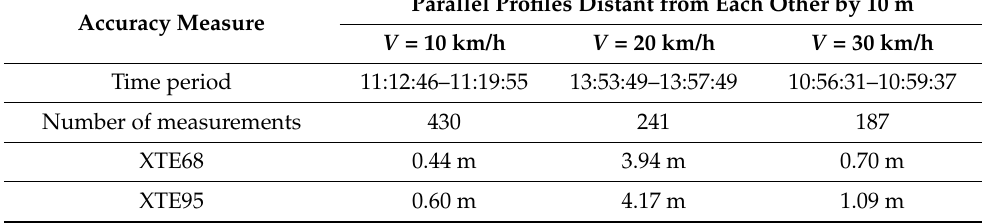
Table 3. The accuracy measures of steering a UAV for the route comprising parallel profiles distant from each other by 10 m.